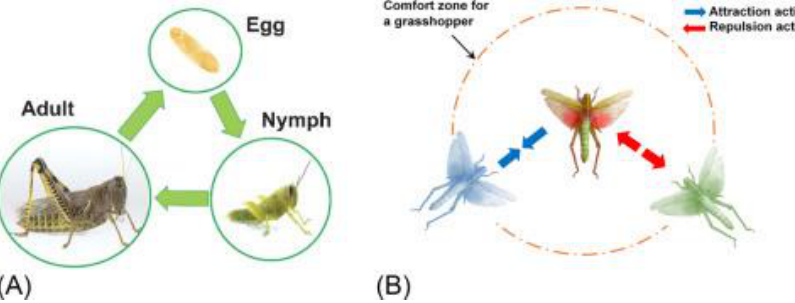
Figure 4. ( A ) Major stages in the lifecycle of grasshoppers, ( B ) Social interaction and swarming behavior of